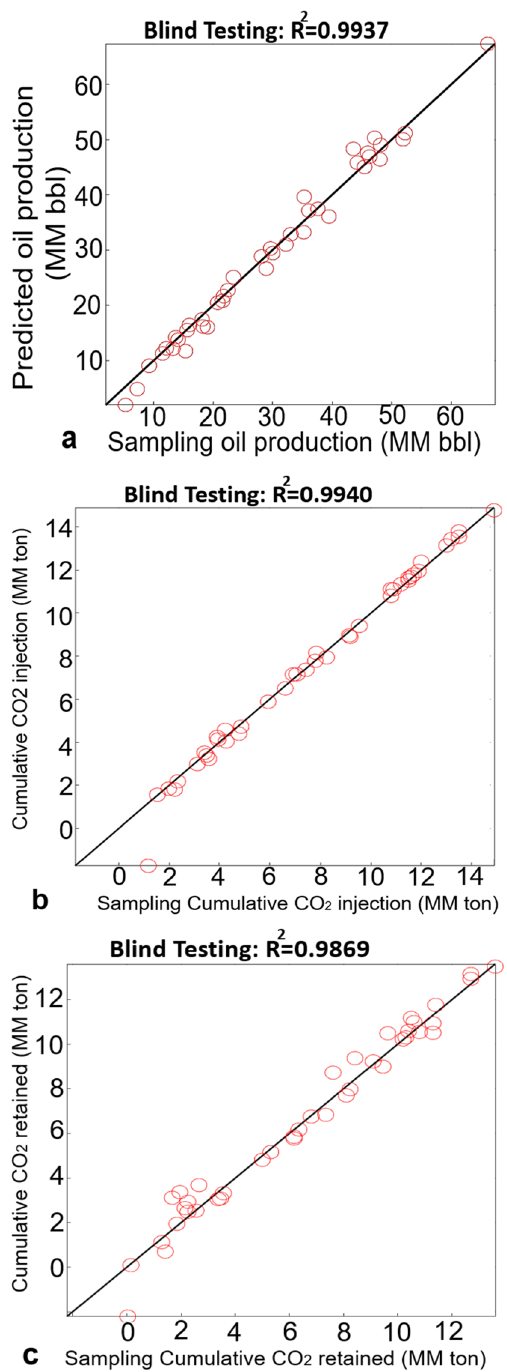
Figure 7. The blind testing of the data-driven ANN models. ( a ) The blind testing result of cumulative oil production with R 2 greater than 0.993. ( b ) The excellent blind testing of cumulative CO 2 stored with R 2 greater than 0.994. ( c ) The greater 98% R 2 for the blind testing of cumulative CO 2